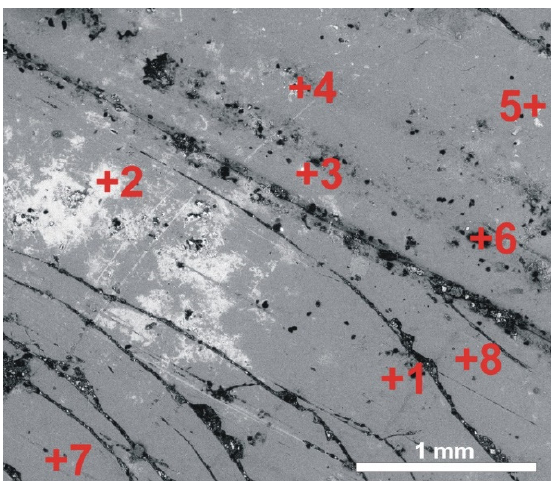
Figure 7. Backscattered electron (BSE) image of the underside surface of the blue bead. For chemical analyses obtained at the points numbered 1–8, see Table 3. Table 3. Chemical composition, in weight percentage, of the underside of the blue bead. For all elements (except anion Cl) the composition is expressed as oxides weight %. The exact positions of the analysed points are shown in Figure 7.